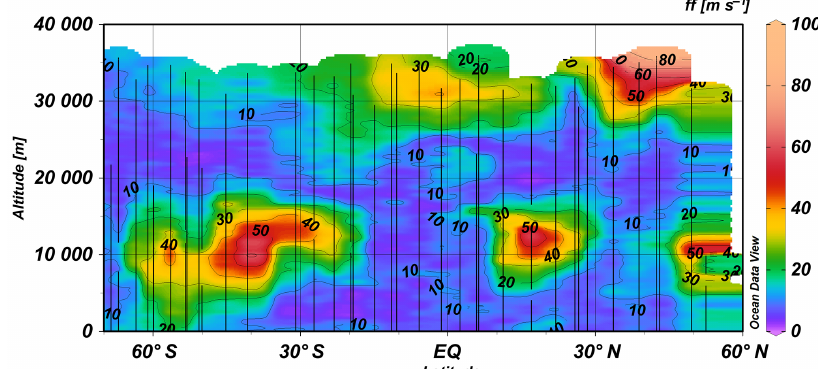
Figure 7. Meridional-height section of wind velocity (ff inms − 1 ) from POLARSTERN cruise ANT-XVII (14 December 1999 to 20 Jan- uary 2000). The lines represent the actual launches, the data were then interpolated to obtain this figure.